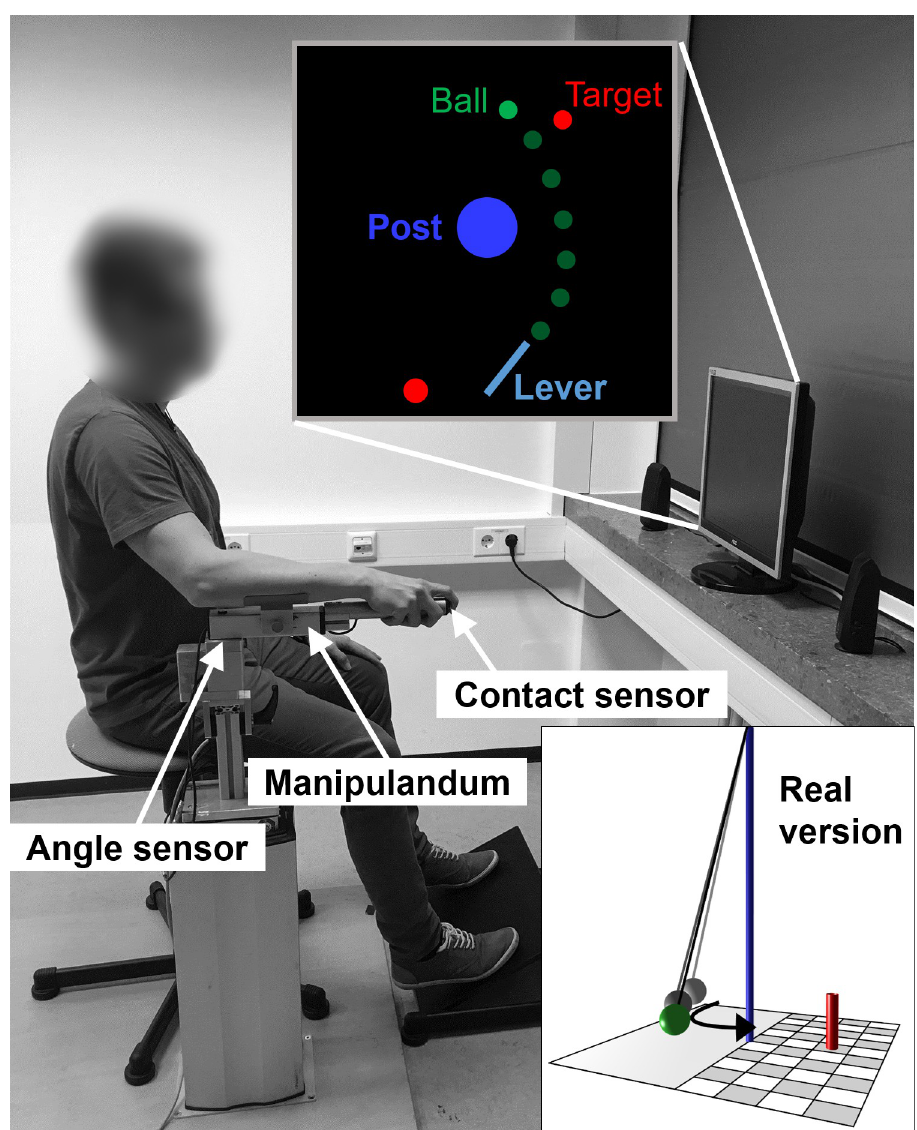
Fig 1. Experimental setup of the Skittles task. The participant uses a manipulandum to throw the virtual ball (green) with a horizontal rotational movement. The ball is released by lifting off the index finger from a contact sensor at the tip of the manipulandum. The ball travels on an elliptical pathway around the blue post to hit a red target. The individual on the picture has given written informed consent to publish these case details.